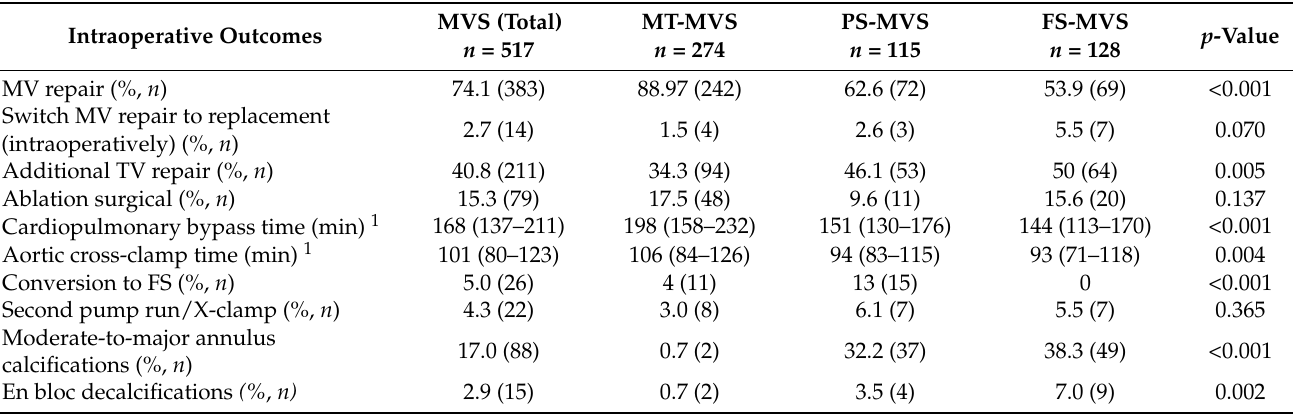
Table 3. Secondary intraoperative outcomes.